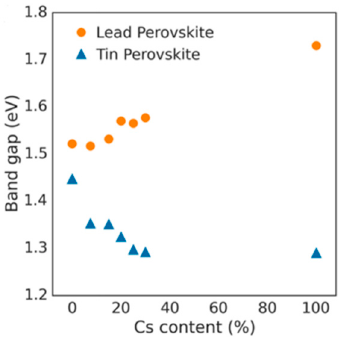
Figure 13. Optical band gap as function of cesium content for perovskites (FA 1 − x Cs x )MI 3 , with M = Pb or M = Sn. Reproduced with permission from J. Am. Chem. Soc. 2017 , 139 , 11117–11124 . Reference [42].